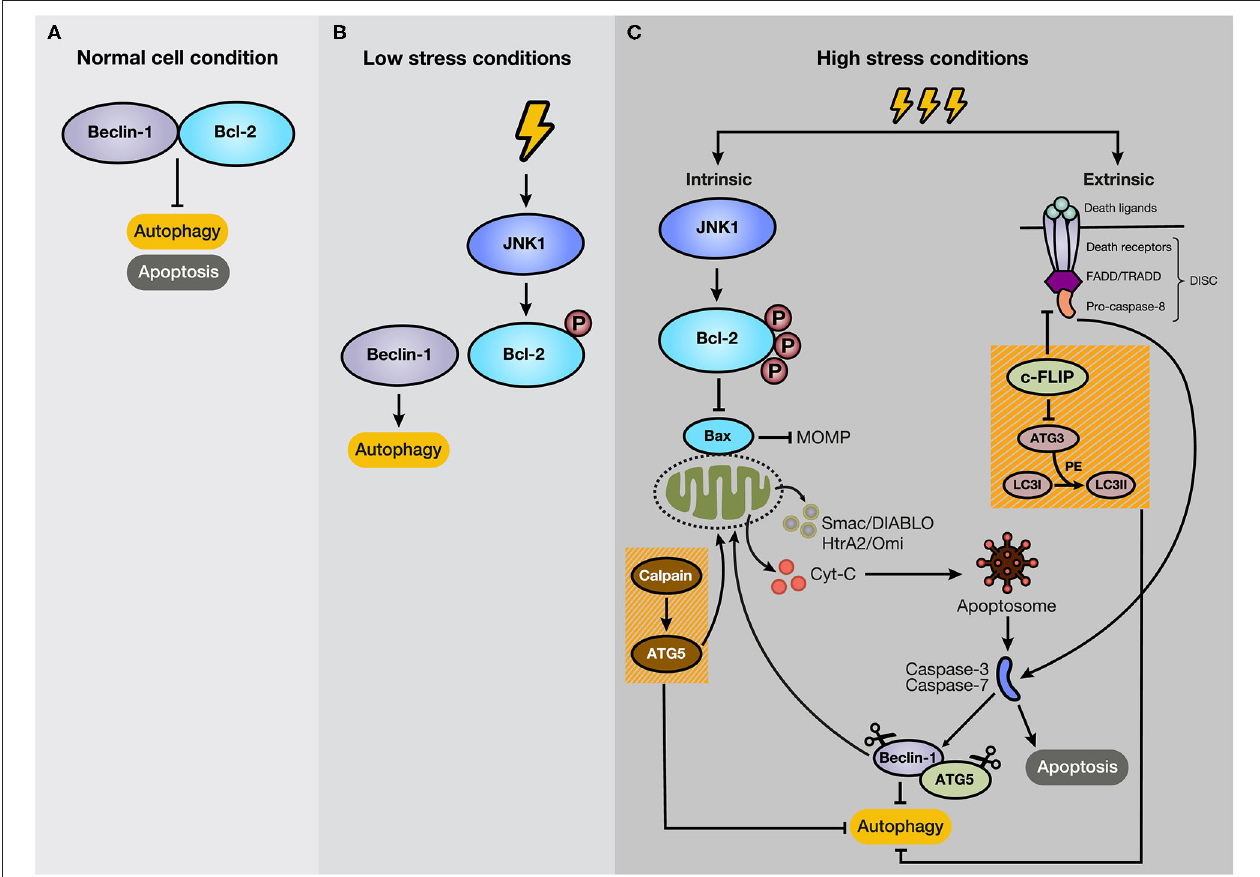
FIGURE 3 | Mechanism of crosstalk between autophagy and apoptosis. (A) Under normal cellular conditions, Beclin-1 binds to Bcl-2, keeping autophagy and apoptosis inactivated. (B) However, if the cell experiences low-level stress conditions (e.g., nutrient deprivation), JNK1 phosphorylates Bcl-2, disturbing Bcl-2/Beclin-1 union. As a result, isolated Beclin-1 activates the autophagic pathway. (C) However, if the stressful stimulus crosses a threshold of time, JNK1 promotes Bcl-2 hyperphosphorylation, inducing its dissociation with Bax and the subsequent activation of the intrinsic apoptotic pathway. In addition, c-FLIP, a suppressor of extrinsic apoptosis, also inhibits autophagy through interaction with ATG3, reducing LC3 lipidation. Moreover, caspase activation mediates autophagy-related proteins, such as Beclin-1 and ATG5. Additionally, the C-terminal fragment generated by caspase-mediated cleavage of Beclin-1 translocates to the mitochondrial membrane and stimulates intrinsic apoptosis. Furthermore, ATG5, after cleavage by calpains, suppresses autophagy activity and induces apoptosis.